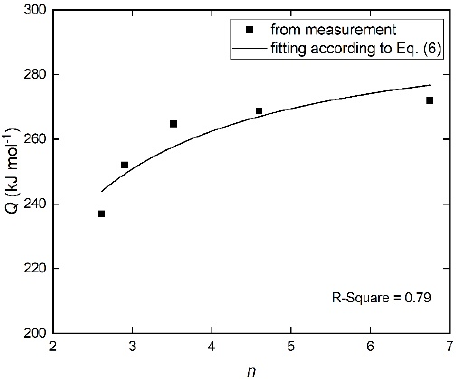
Figure 6. The evolution of the overall effective activation energy Q and the Avrami (growth) exponent n with heating rates of 5–40 K min − 1 . The separate activation energy for nucleation and growth is obtained by fitting Equation (6) to the data points with n and Q values listed in Table 1. The result is Q N = 297 ± 10 kJ mol − 1 , Q G = 204 ± 33 kJ mol − 1 , with an R-square value of about 0.79.